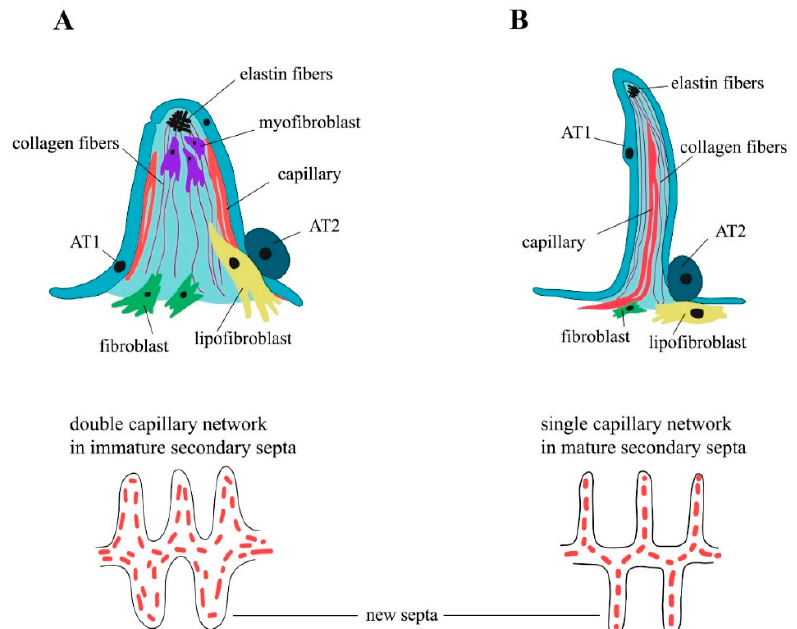
Figure 2. Alveolar secondary septa. Classical alveologenesis. Immature, thick secondary septa. Double capillary network ( A ). Continued alveologenesis. Mature, thin secondary septa. Single capillary network ( B ). Redrawn from [23,26].